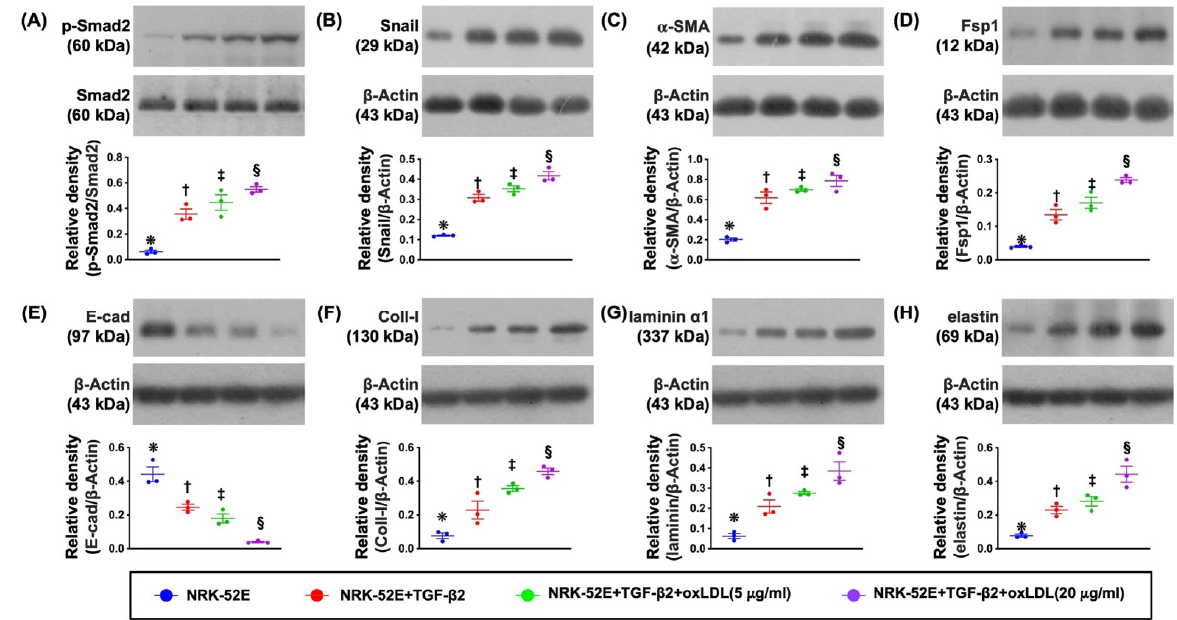
Figure 1. Protein expressions of EMT biomarkers in NRK-52E cells treated by TGF- β and oxidized LDL. ( A ) Protein expression of phosphorylated (p)-Smad2, * vs. other groups with different symbols (†, ‡, §), p < 0.001. ( B ) Protein expression of Snail, * vs. other groups with di ff erent symbols (†, ‡, §), p < 0.001. ( C ) Protein expression of alpha smooth actin ( α -SMA), * vs. other groups with different symbols (†, ‡, §), p < 0.001. ( D ) Protein expression of fibroblast-specific protein 1 (Fsp1), * vs. other groups with di ff erent symbols (†, ‡, §), p < 0.001. ( E ) Protein expression of E-cadherin (E-cad), * vs. other groups with di ff erent symbols (†, ‡, §), p < 0.001. ( F ) Protein expression of collagen type I (Coll-I), * vs. other groups with di ff erent symbols (†, ‡, §), p < 0.001. ( G ) Protein expression of laminin, * vs. other groups with di ff erent symbols (†, ‡, §), p < 0.001. ( H ) Protein expression of elastin, * vs. other groups with di ff erent symbols (†, ‡, §), p < 0.001. All statistical analyses were performed by one-way ANOVA, followed by Bonferroni multiple comparison post hoc test (n = 3 for each group). Symbols (*, †, ‡, §) indicate signi fi cance for each other (at 0.05 level). TGF- β = transforming growth factor-beta; EMT = epithelial mesenchymal transition; LDL = low-density lipoprotein.